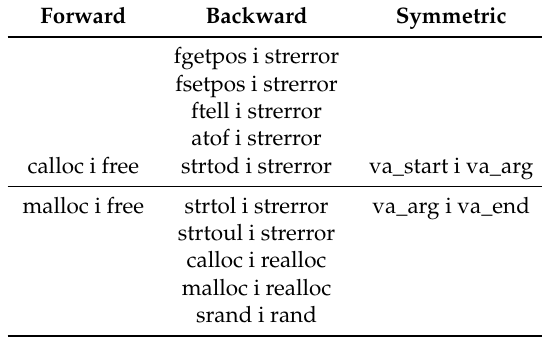
Table 2. Examples of relations developed on the basis of the C language standard library function description